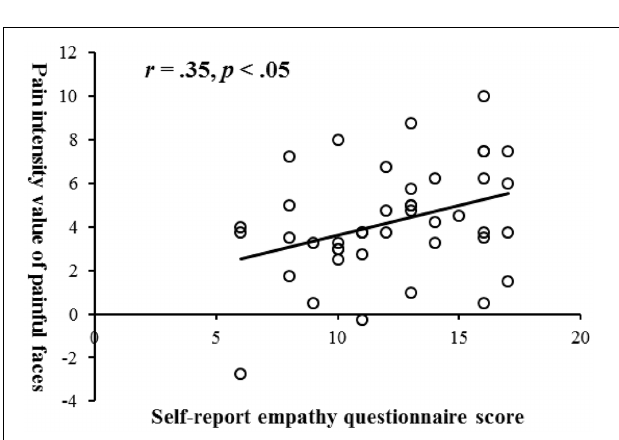
FIGURE 8 | Scatterplot for the correlation between empathy and pain intensity value of painful facial expression with linear regression